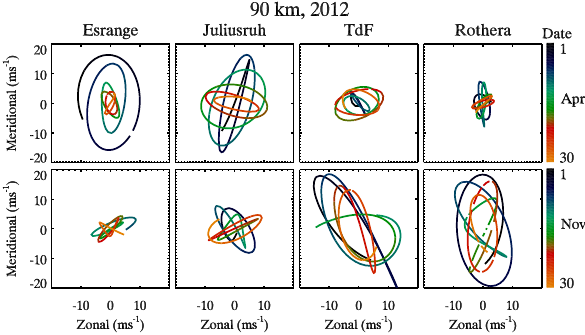
Figure 7. Same as Fig. 5, but for April (top) and November (bottom) in